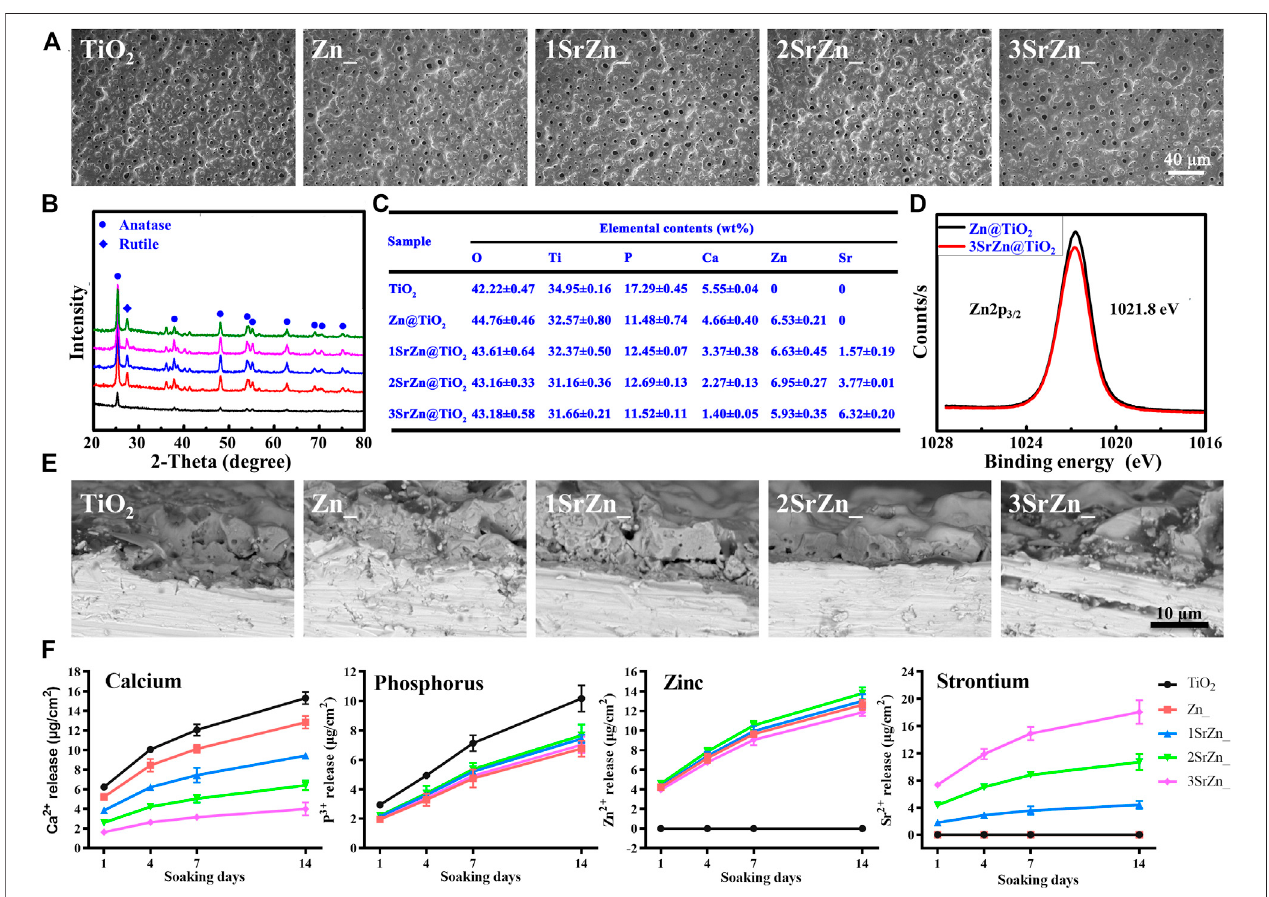
FIGURE 3 | Materials characterization. (A) SEM images of the surface microstructure of pure TiO 2 and Zn and/or Sr-doped TiO 2 samples after PEO treatment. (B) XRD spectra of the samples. (C) EDS mapping of the major elements in the coatings of the samples. (D) XPS spectra of Zn2p 3/2 . (E) SEM images showing the cross section of the samples. (F) ICP-MS determination of Ca, P, Sr, and Zn ions released from samples after 1, 4, 7, and 14 days.